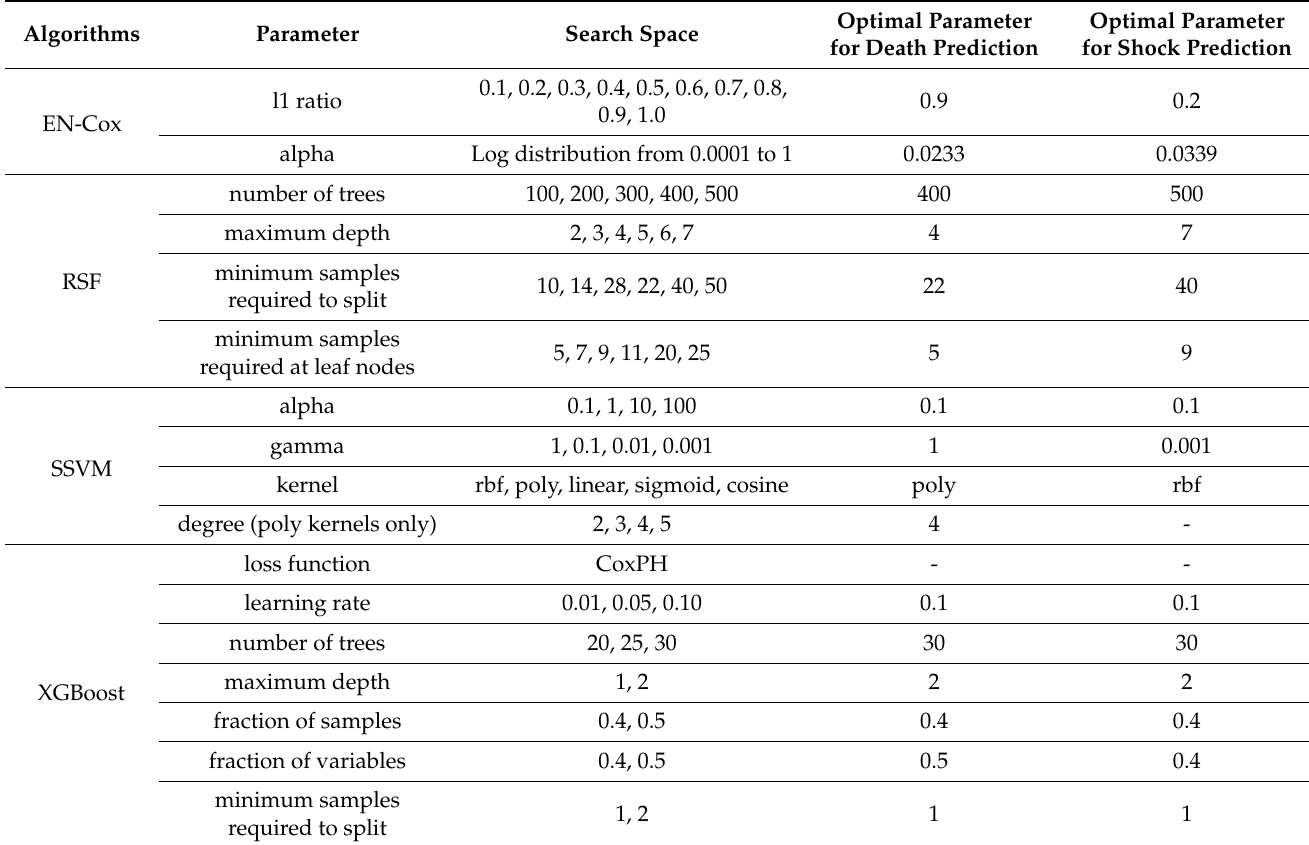
Table 2. Parameter search space and optimal parameters for each model.